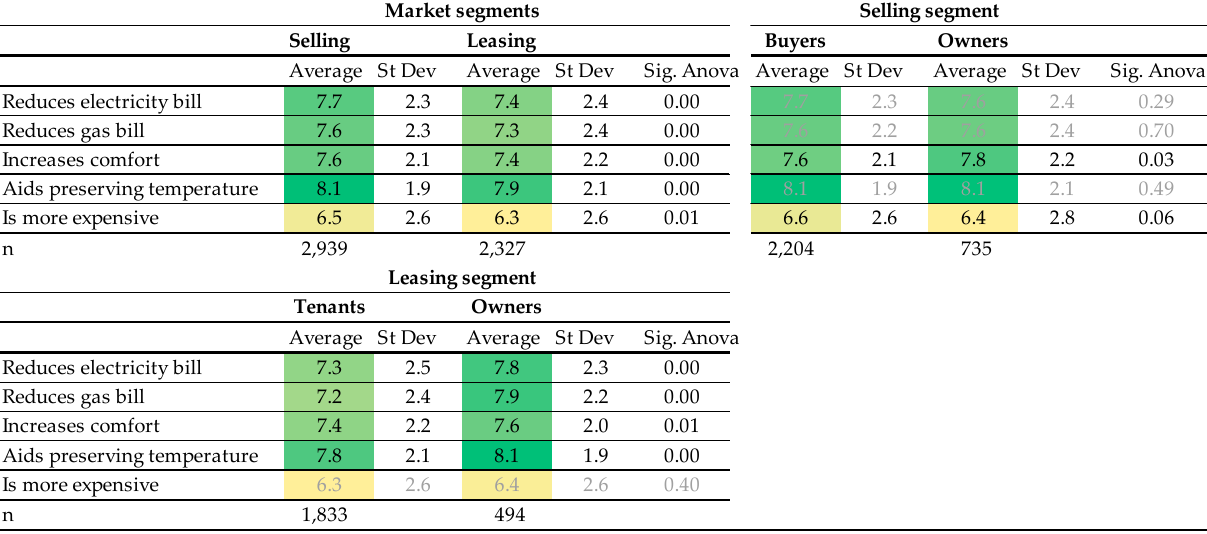
Figure 4. Perceived benefits according to market segments and offer/demand sides. Source: Self elaboration.